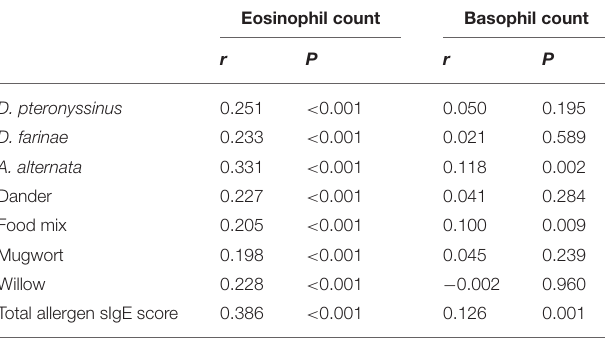
TABLE 2 | Correlations between levels of sIgE and eosinophil count, basophil count, respectively. Eosinophil count Basophil